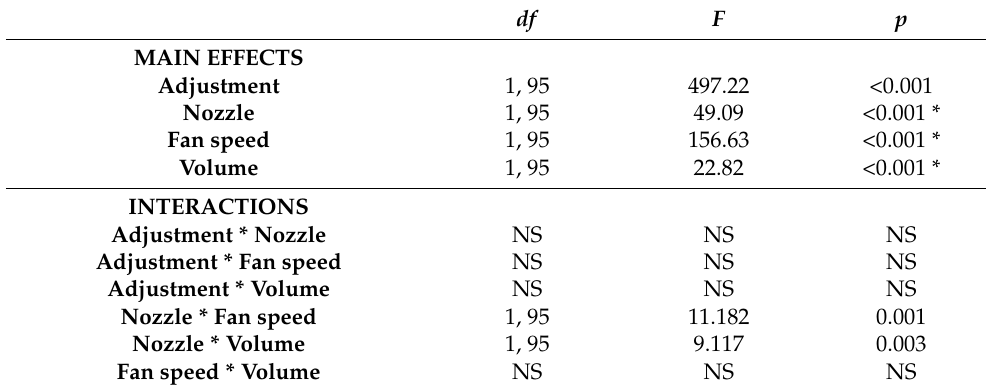
Table 9. Two-way ANOVA results for the normalized volume collected in the canopy zone with the C2 sprayer (least significant difference (LSD) test, p < 0.05) a .